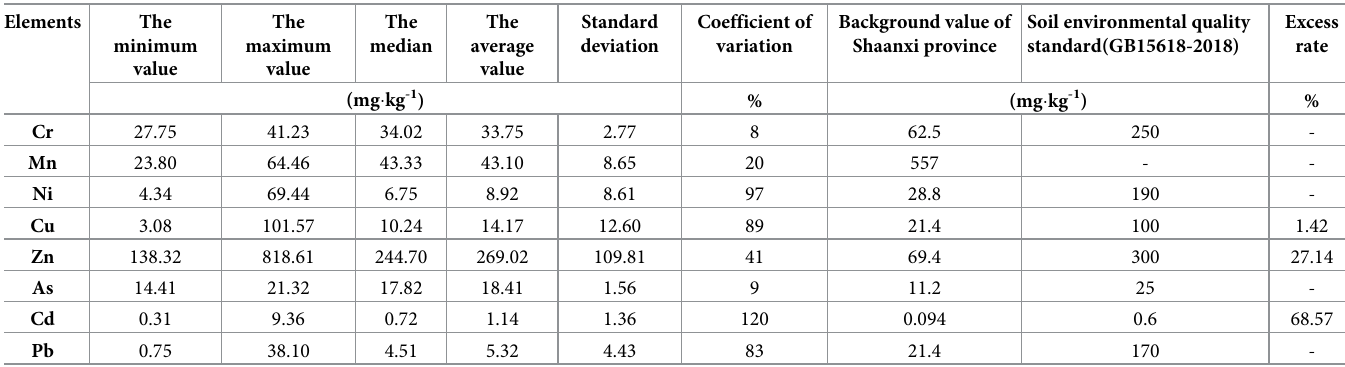
Table 4. Heavy metal contents in soil of study area (n = 70). The